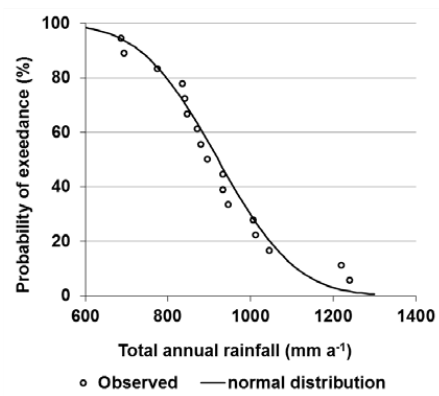
Figure 4. Probability plot of the total annual rainfall for the Vea and Bongo irrigation schemes for 1998–2014.